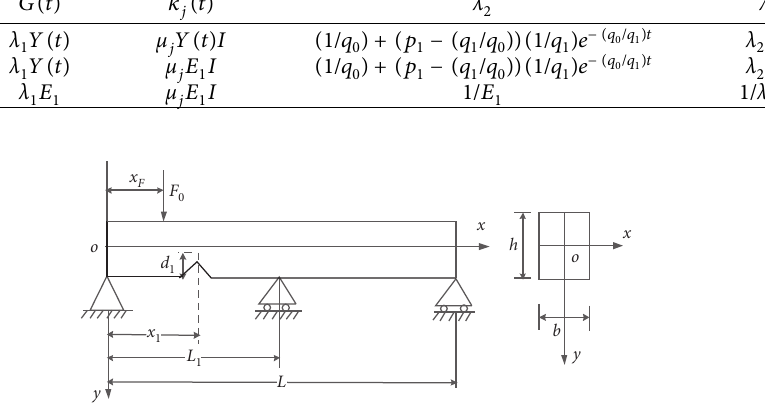
Figure 3: Geometric parameters of the continuous viscoelastic cracked